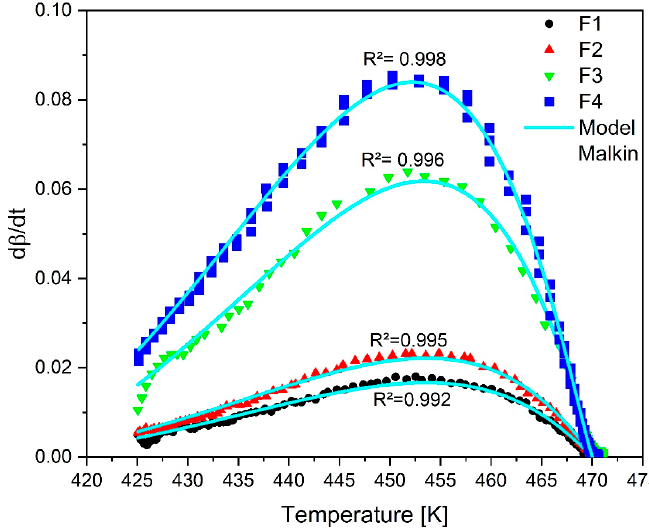
Figure 3. Comparison of the measured values and model fits using Malkin’s model for formulations F1–F4.